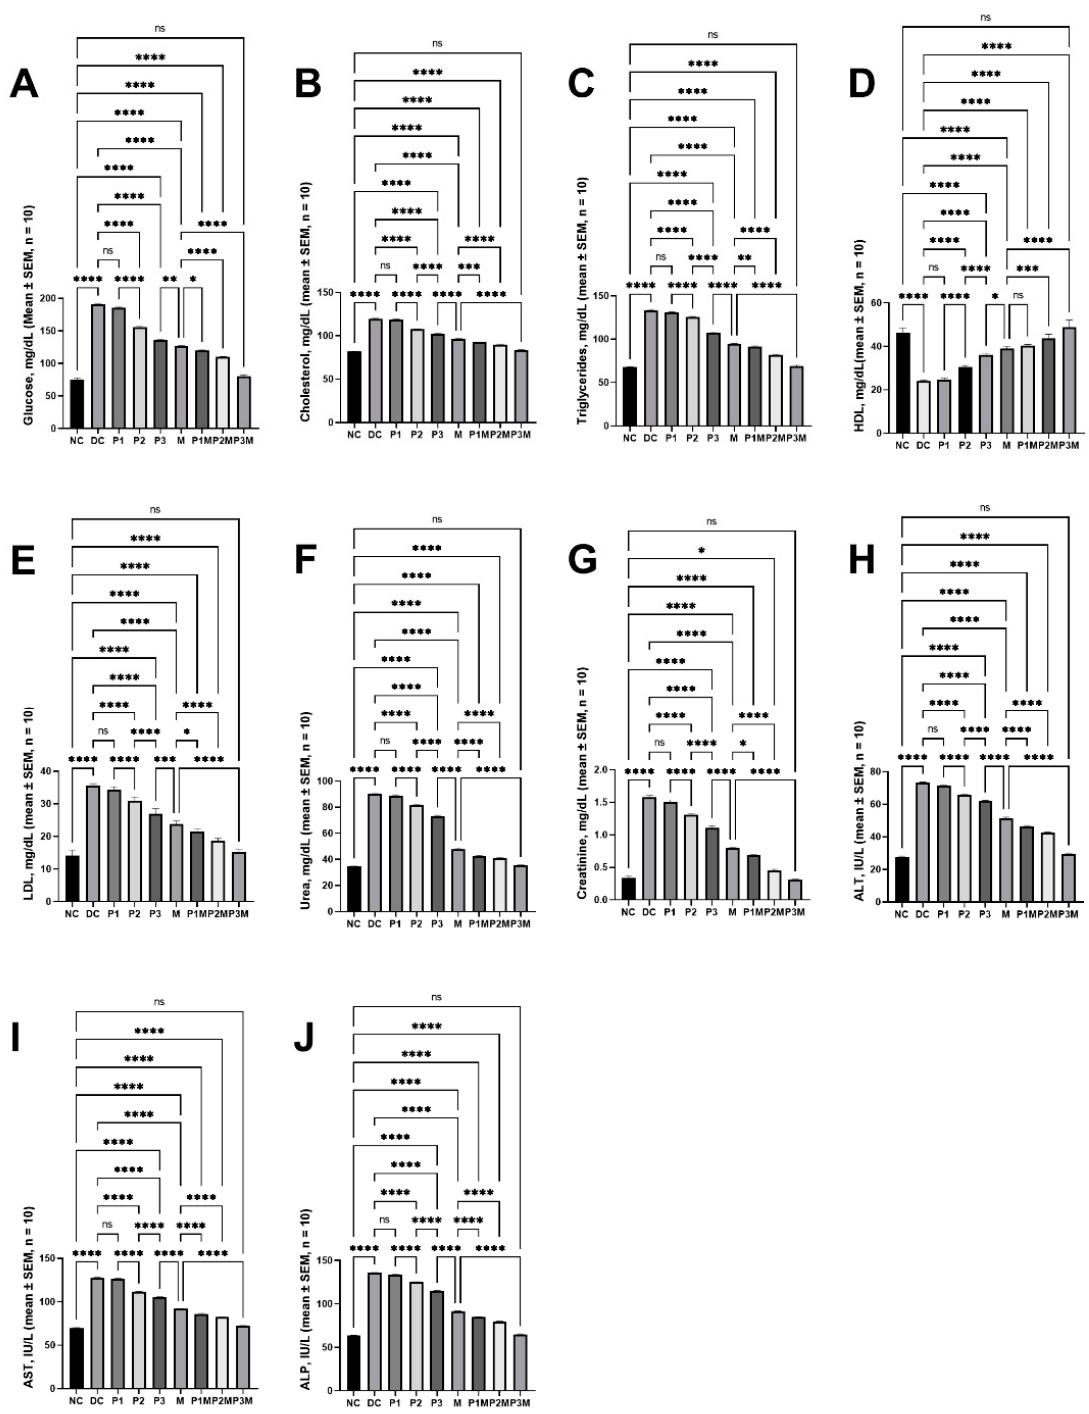
Figure 1. The effects of the pharmacodynamic activity of puerarin and metformin and the pharmacodynamic interaction between puerarin and metformin on serum biochemical parameters. ( A ) Hyperglyceamia, ( B ) cholesterol, ( C ) triglycerides, ( D ) HDL, ( E ) LDL, ( F ) urea, ( G ) creatinine, ( H ) ALT, ( I ) AST, ( J ) ALP. The groups are represented as follows: NC, normal control; DC, diabetic control; P1, puerarin (80 mg/kg); P2, puerarin (120 mg/kg); P3, puerarin (160 mg/kg); M, metformin (100 mg/kg); P1M, puerarin (80 mg/kg) + metformin (100 mg/kg); P2M, puerarin (120 mg/kg) + metformin (100 mg/kg); P3M, puerarin (160 mg/kg + metformin (100 mg/kg).The annotations on the pairwise comparisons are as follows: ns, not significant ( p > 0.05); *, p ≤ 0.05; **, p ≤ 0.01; ***, p ≤ 0.001; ****, p ≤ 0.0001.